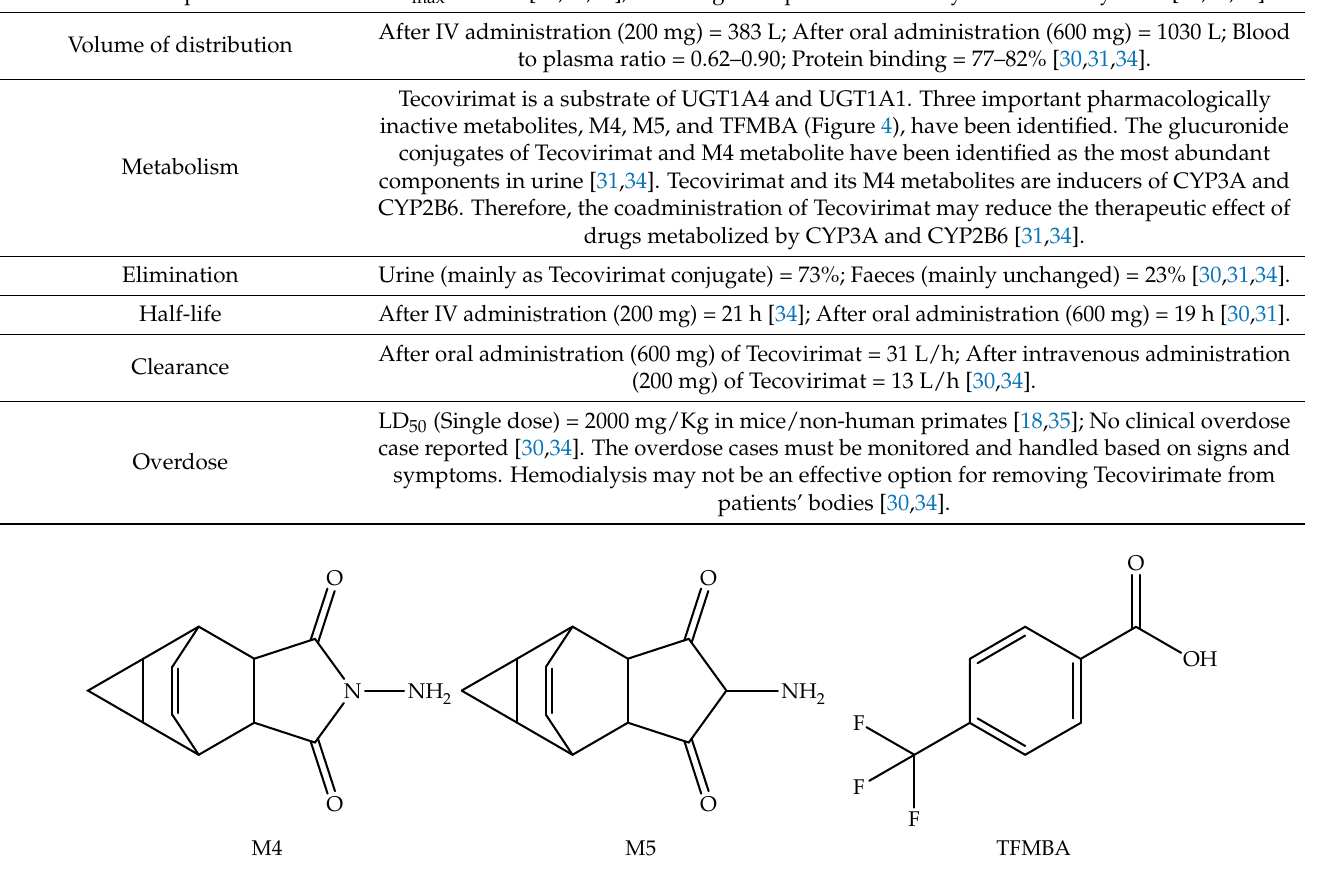
Figure 4. Pharmacologically inactive metabolites of Tecovirimat.